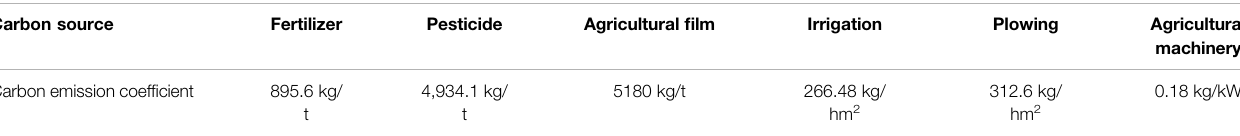
TABLE 1 | Agricultural carbon emission sources and coef fi